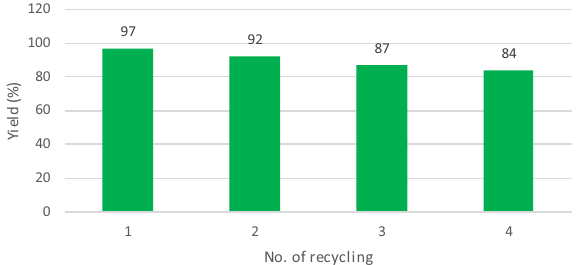
Figure 6. Recycling chart for the Melamine@TMG nanocatalyst 1 in the synthesis of 5a .